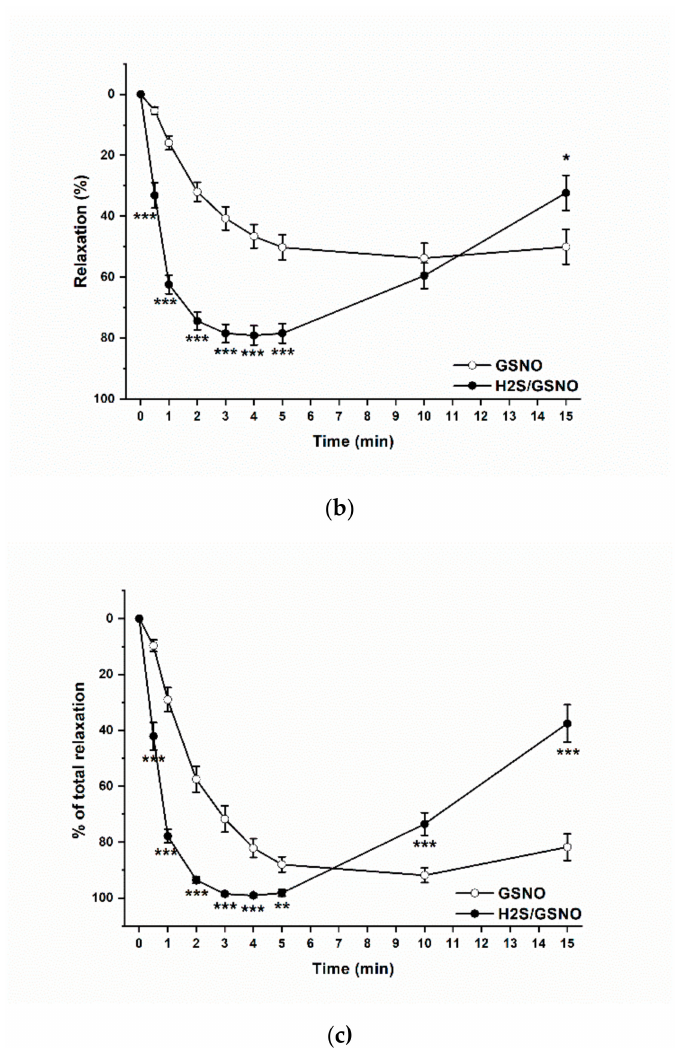
Figure 4. The comparison of the vasorelaxation induced by GSNO alone and by H 2 S / GSNO products. The comparison of the maximal relaxation ( a ) and the absolute ( b ) as well as the relative ( c ) relaxation in time induced by GSNO (0.5 µ M) alone and by H 2 S / GSNO products (0.5 µ M) ( n = 19). Values are mean ± S.E.M. * p < 0.05; ** p < 0.01; *** p < 0.001 with respect to the value of the GSNO